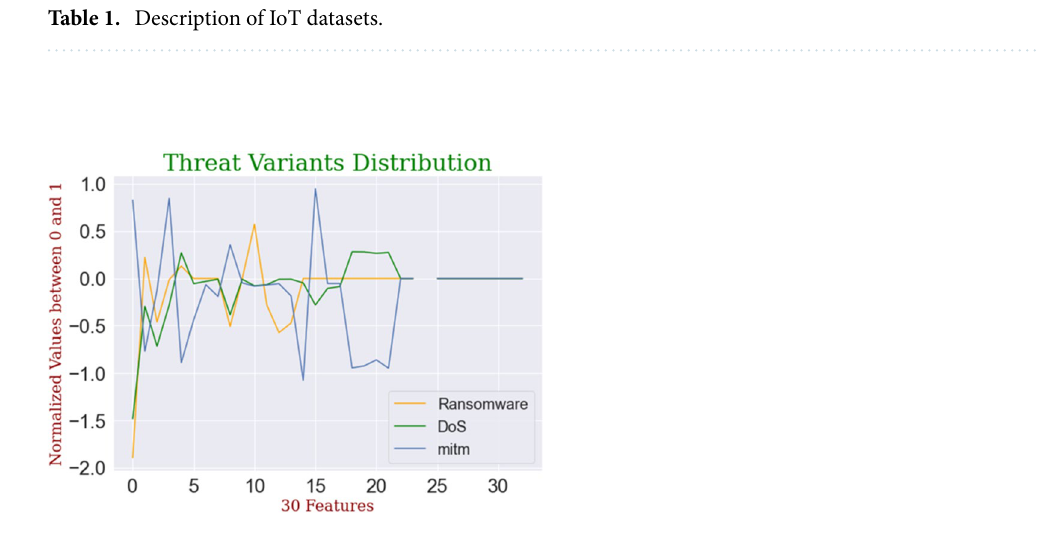
Figure 9. Distribution of different